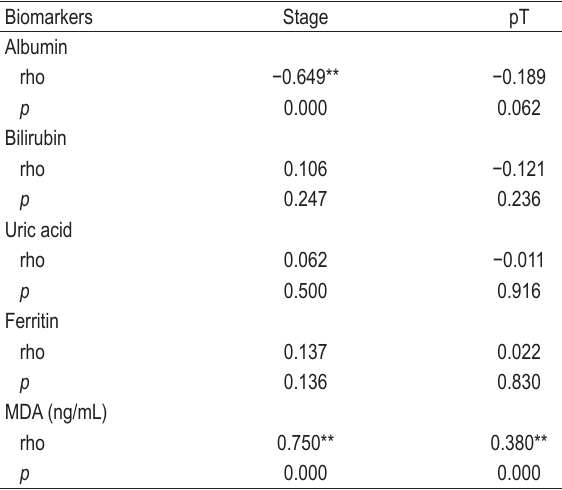
TABLE 3. Correlation of monitored biomarkers with stage of CRC and depth of tumor